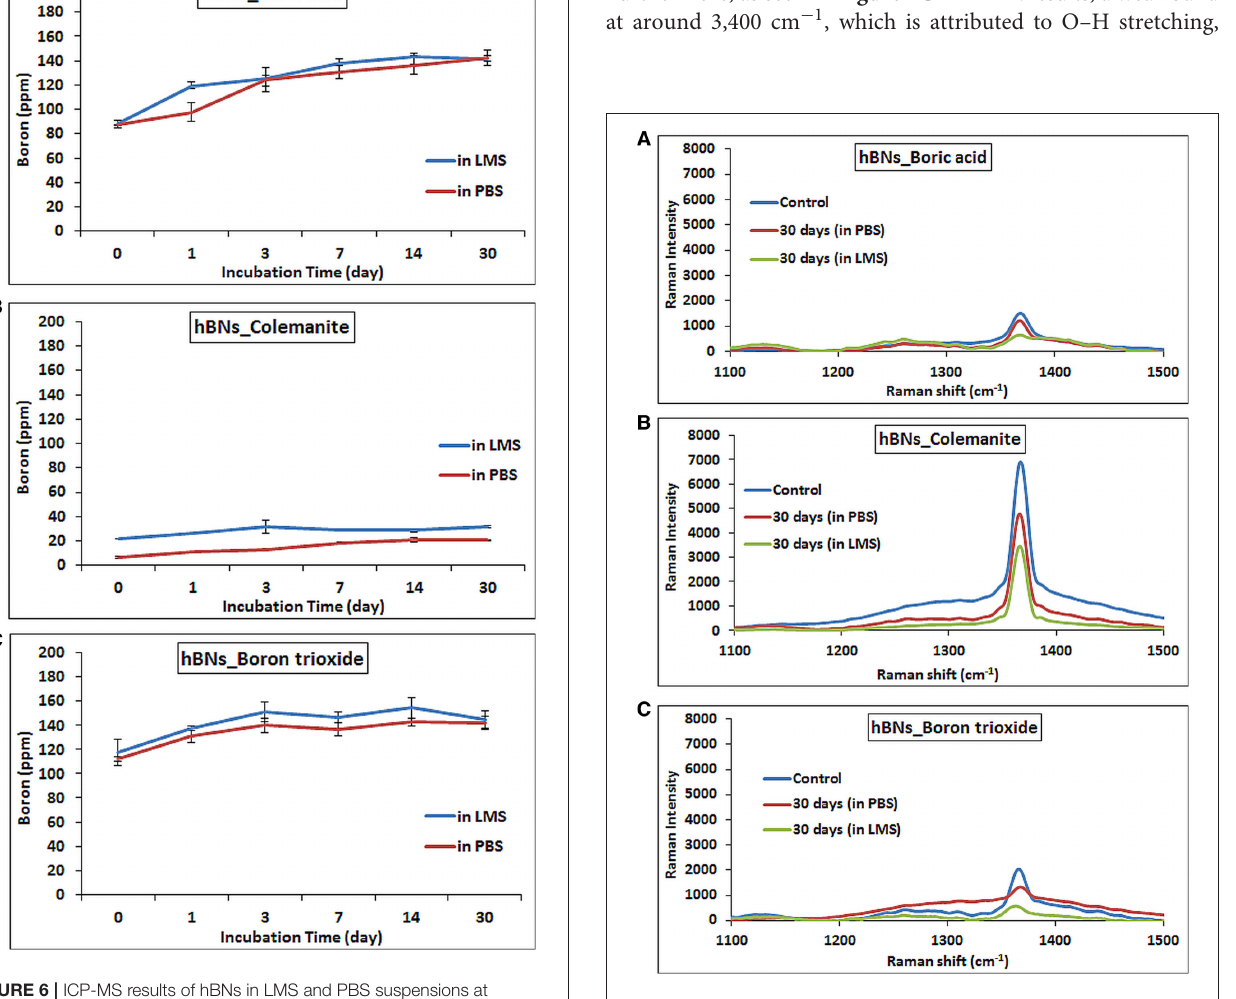
FIGURE 7 | Raman spectra of hBNs before and after biodegradation process. (A) hBNs_boric acid, (B) hBNs_colemanite, and (C) hBNs_boron